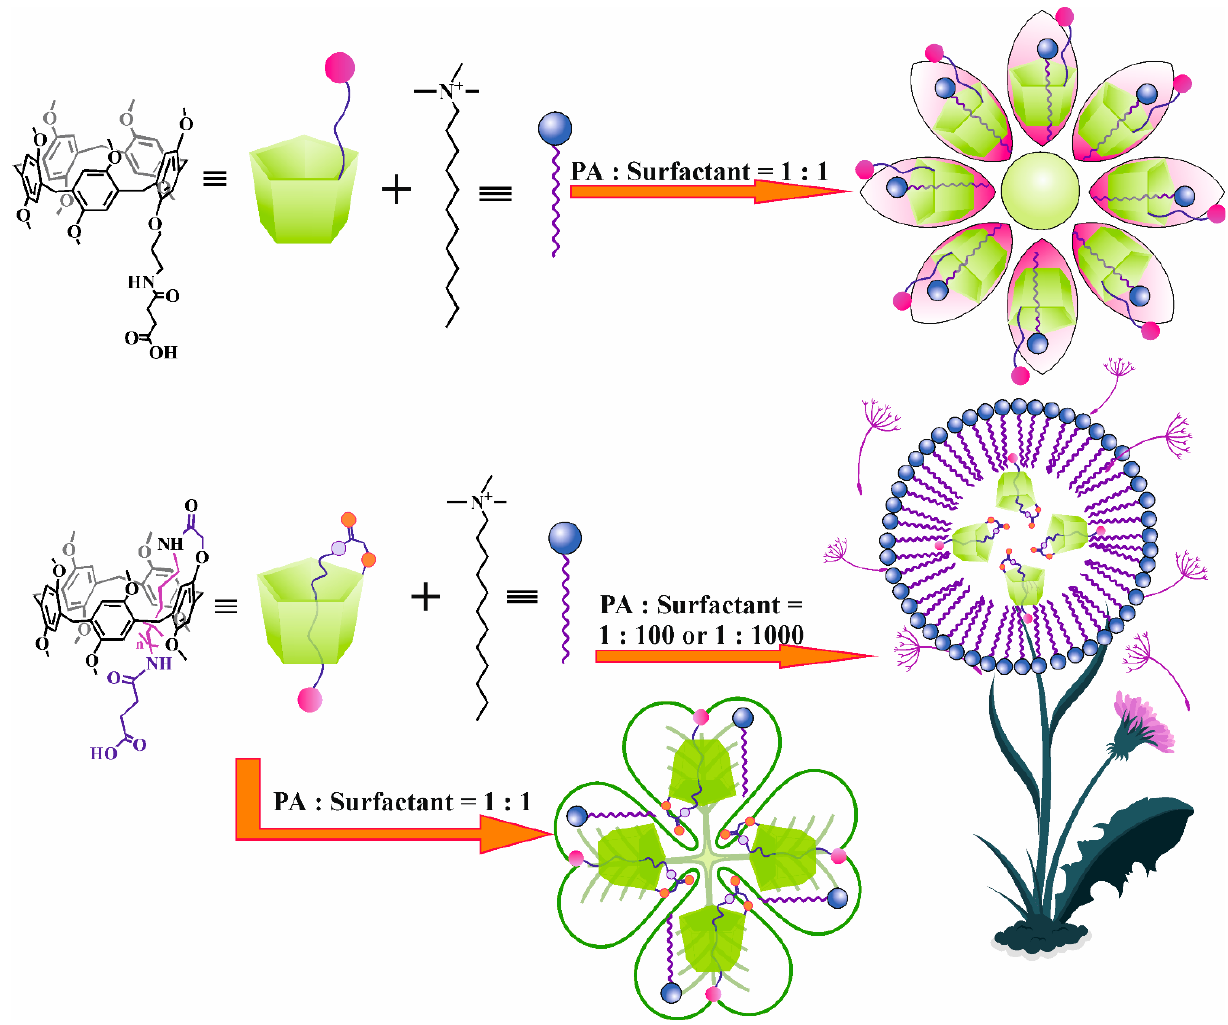
Figure 5. Schematic representation of the resulting aggregates.